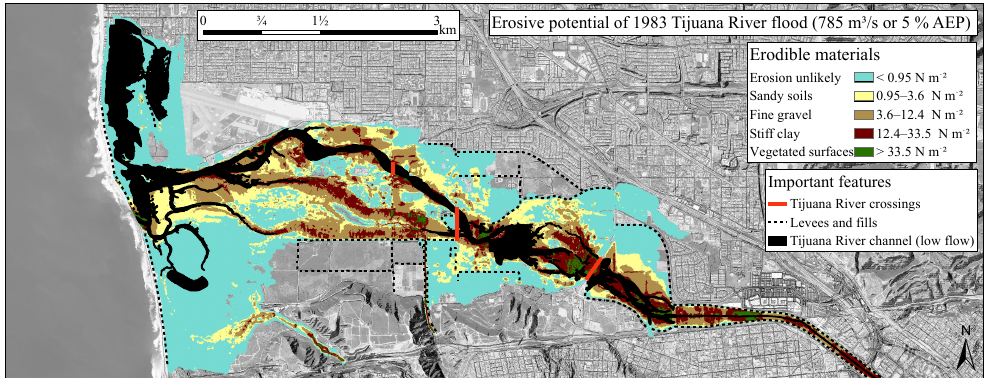
Figure 8. Erosion potential map of the 1983 Tijuana River flood produced for the TRV stakeholders. The contoured flood hazard variable is the maximum depth-averaged shear stress predicted by the hydraulic model during the simulated flood event. Legend thresholds were estimated from Fischenich (2001). The map also includes the locations of levees and fills, Tijuana River crossings, and the Tijuana River